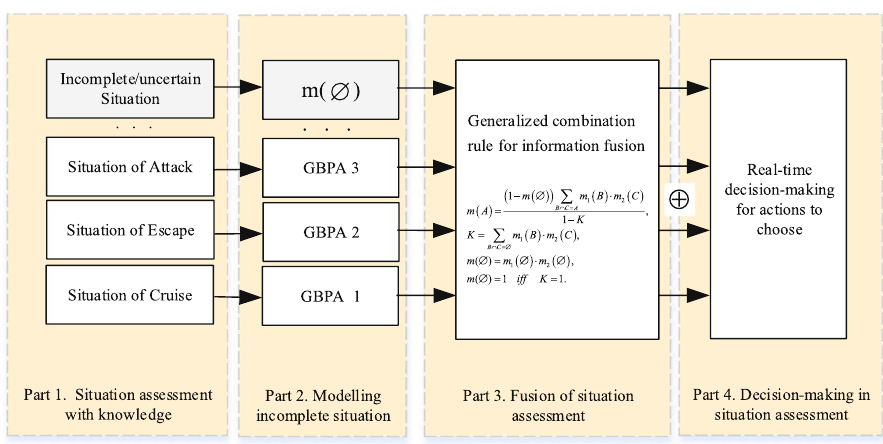
Figure 2. Flow chart of situation assessment considering incomplete information in the evidence